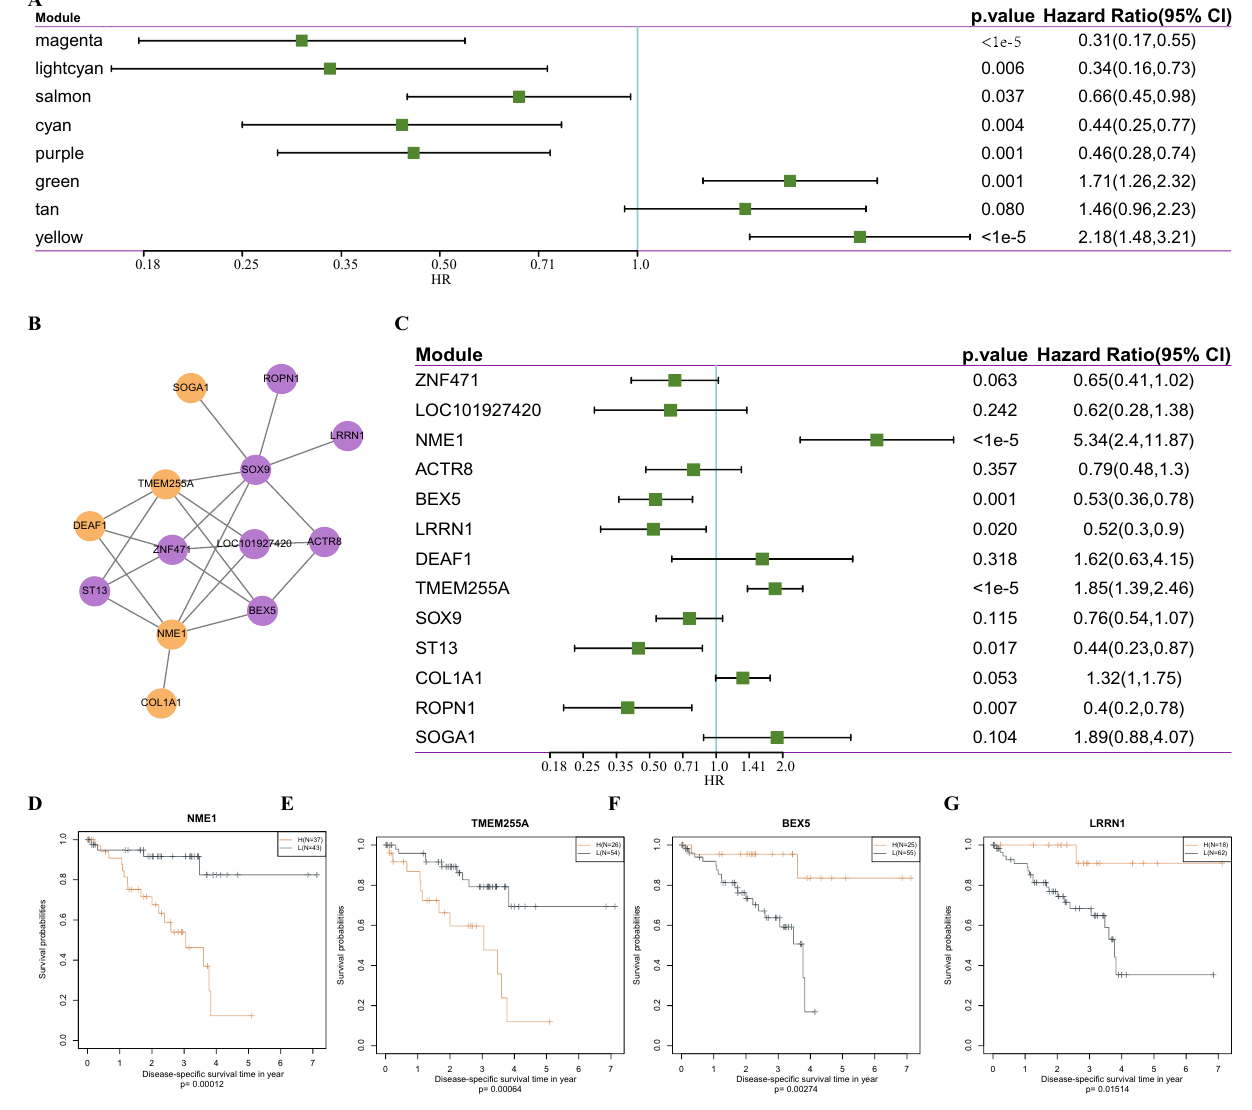
Figure 8. Identification of prognosis- related genes in the module. ( A ) Univariate Cox analysis of the correlation between modules related to LDA score and OS. ( B ) Potential genetic markers associated with LDA score. ( C ) The correlation between 13 genes and UM prognosis was analyzed by univariate Cox analysis. ( D – G ) Kaplan–Meier curves of NME1, TMEM255A, BEX5, and ROPN1 expression in UM